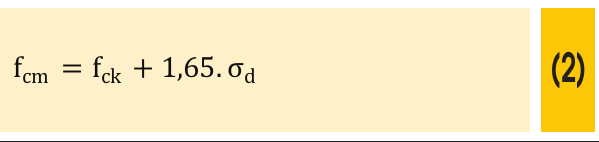
Figure 1 – Results obtained by simulation of a strictly compliant C30